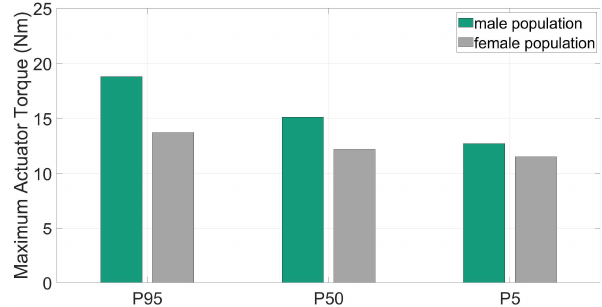
Figure 14. Maximal support torque values for representative individuals of male and female.